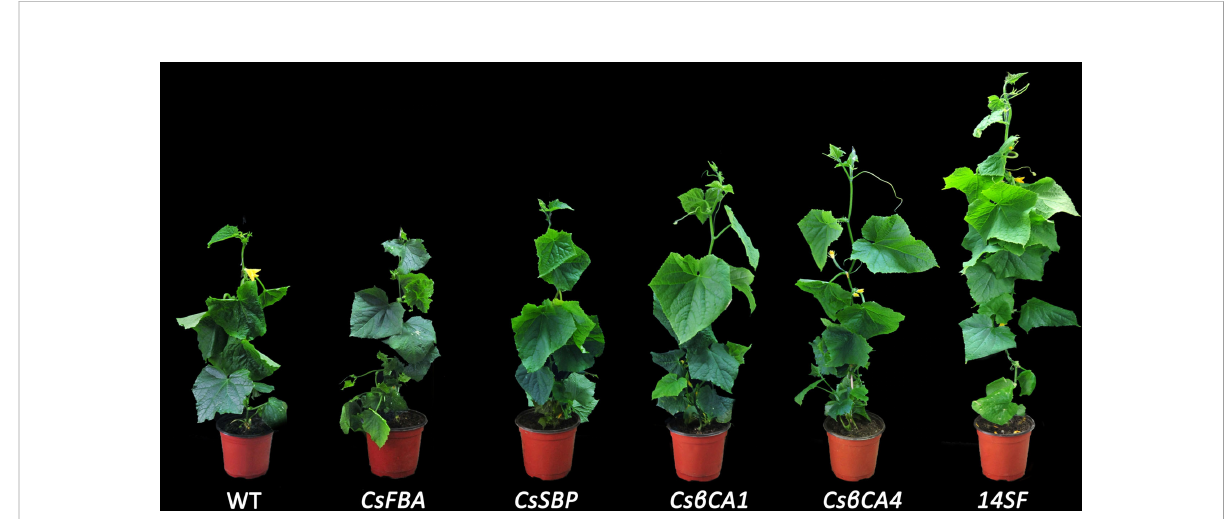
TABLE 2 Comparison of the growth parameters between overexpression lines and the control plants. Plant Stem diame- Leaf Leaf Dry weight of above- height: cm ter: mm length:cm width: cm ground: g